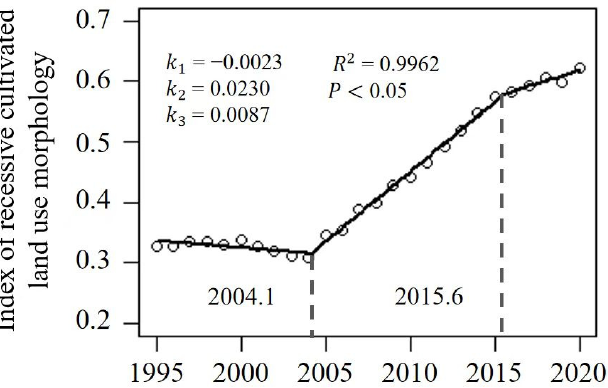
Figure 4. Point mutation detection of the recessive index in the Huaibei region of the Jiangsu province between 1995 and